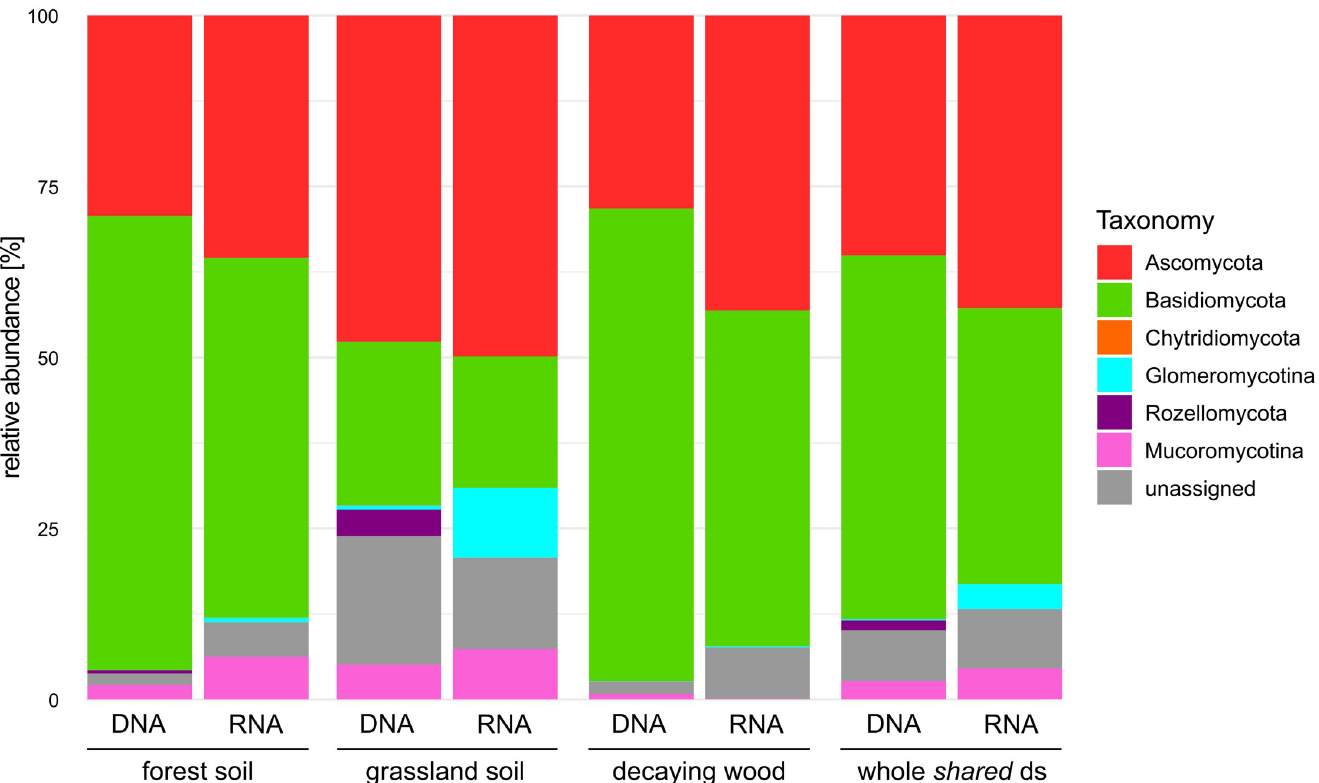
Fig 1. Taxon distribution (phylum or sub-phylum levels) in the eDNA and eRNA datasets. Taxon distribution is visualized for the three studied habitat, forest soil, grassland soil and decaying wood. The “whole shared ds” corresponds to the distribution in the entire dataset (all habitats together). Note the differences in abundances for Glomeromycotina and Rozellomycota between the grassland soil RNA and DNA datasets.